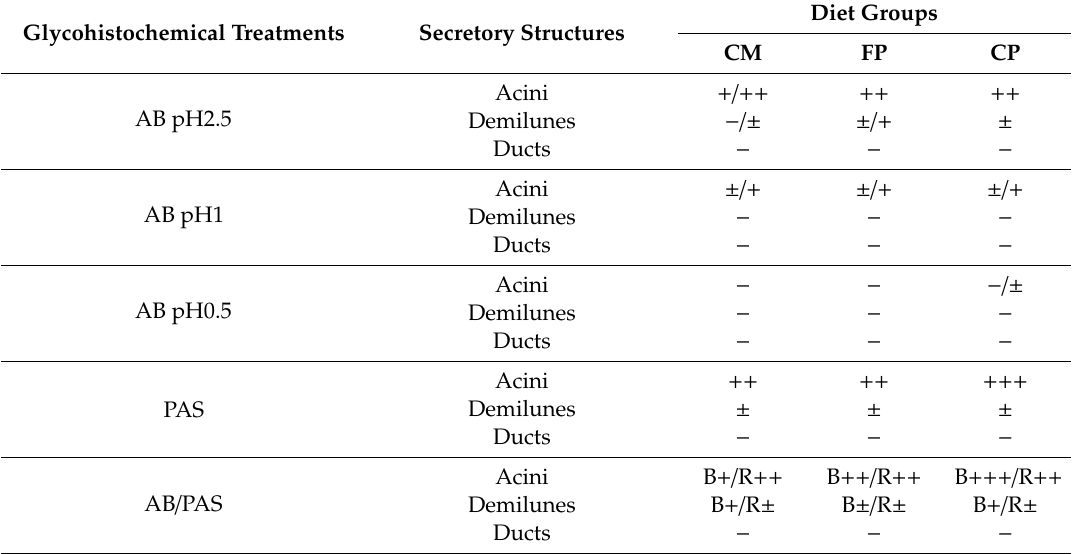
Table 2. Sample reaction intensity expressed in arbitrary units toward glycohistochemical treatments. Glycohistochemical Treatments Secretory